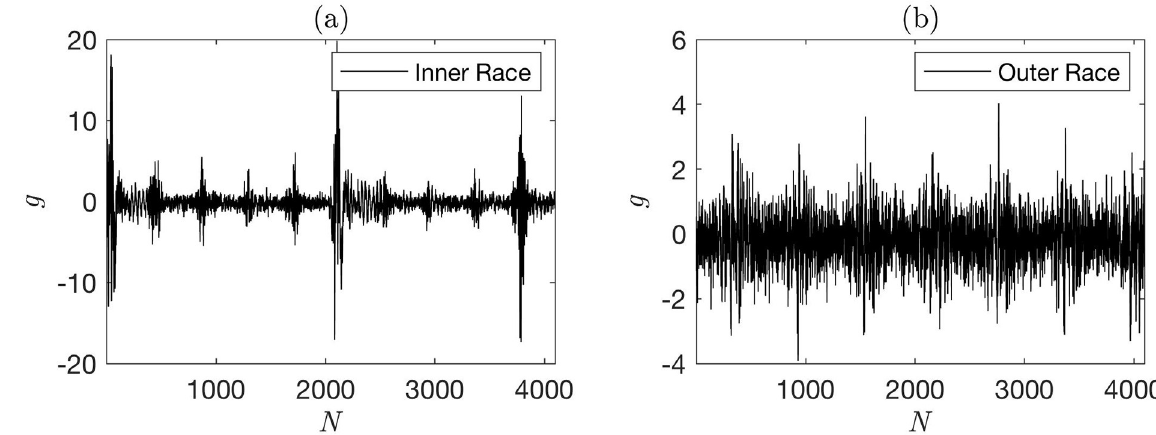
Fig 1. Sample vibration signals representing (a) an inner race fault and (b) an outer race fault.